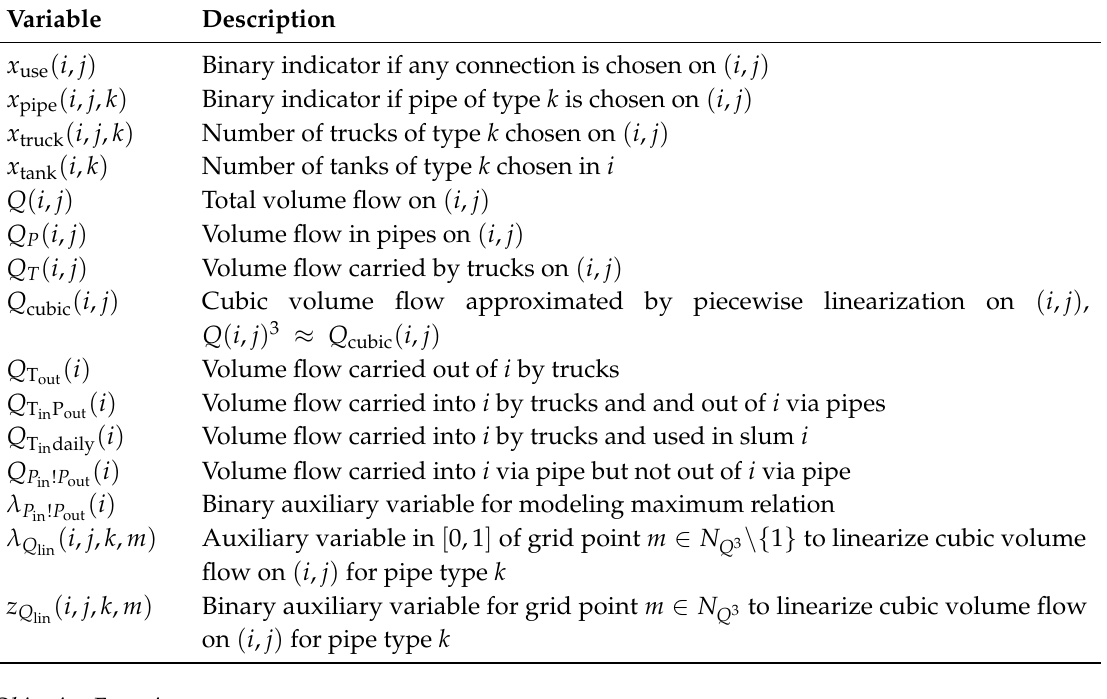
Table A2. Decision variables of the mixed-integer